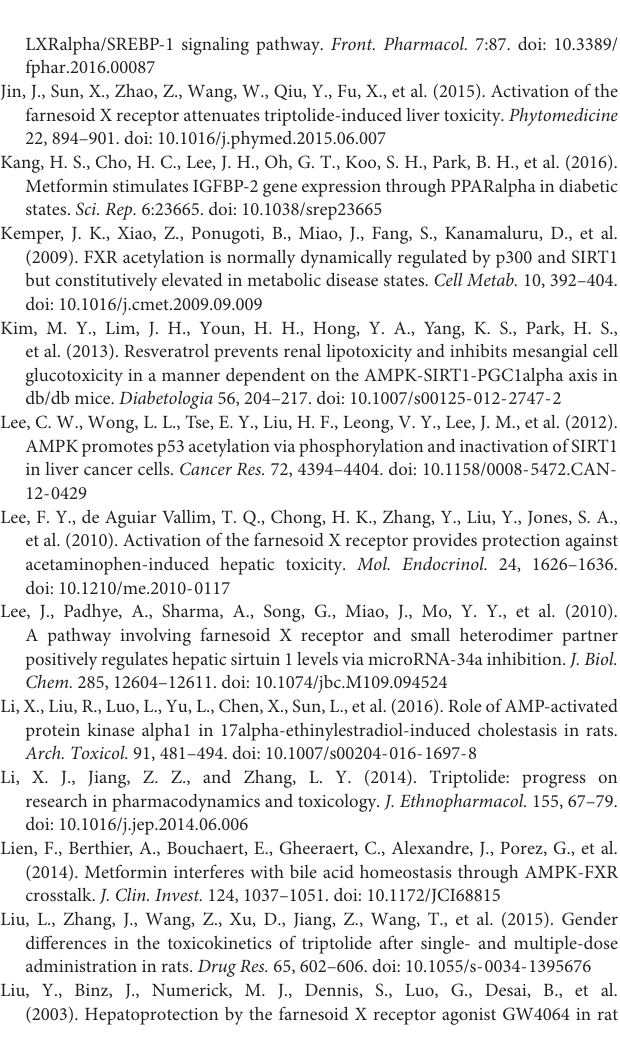
FIGURE S1 | Triptolide (TP)-induced hepatic injury in rat model. Female Wistar rats were treated as previously described in the Materials and Methods. The images of the rat liver were